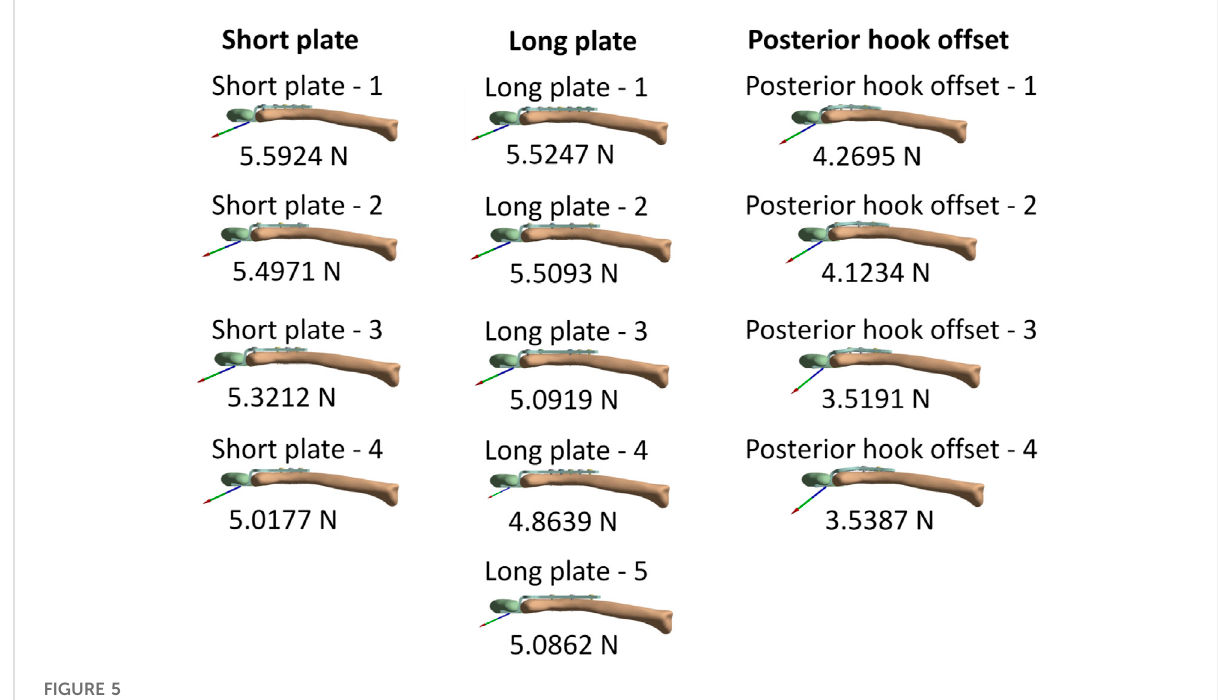
FIGURE 5 Force reaction on the acromion.